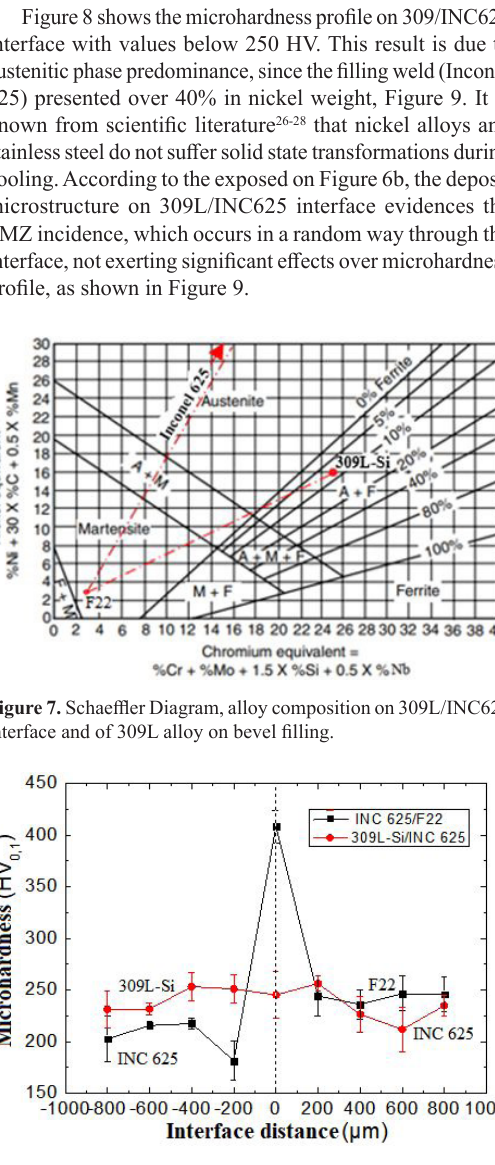
Figure 8. Microhardness profile, J309 welded joint, on 309/INC625 and INC625/F22 interfaces. Figure 9. EDS analysis on 309L-Si/INC625 joint.